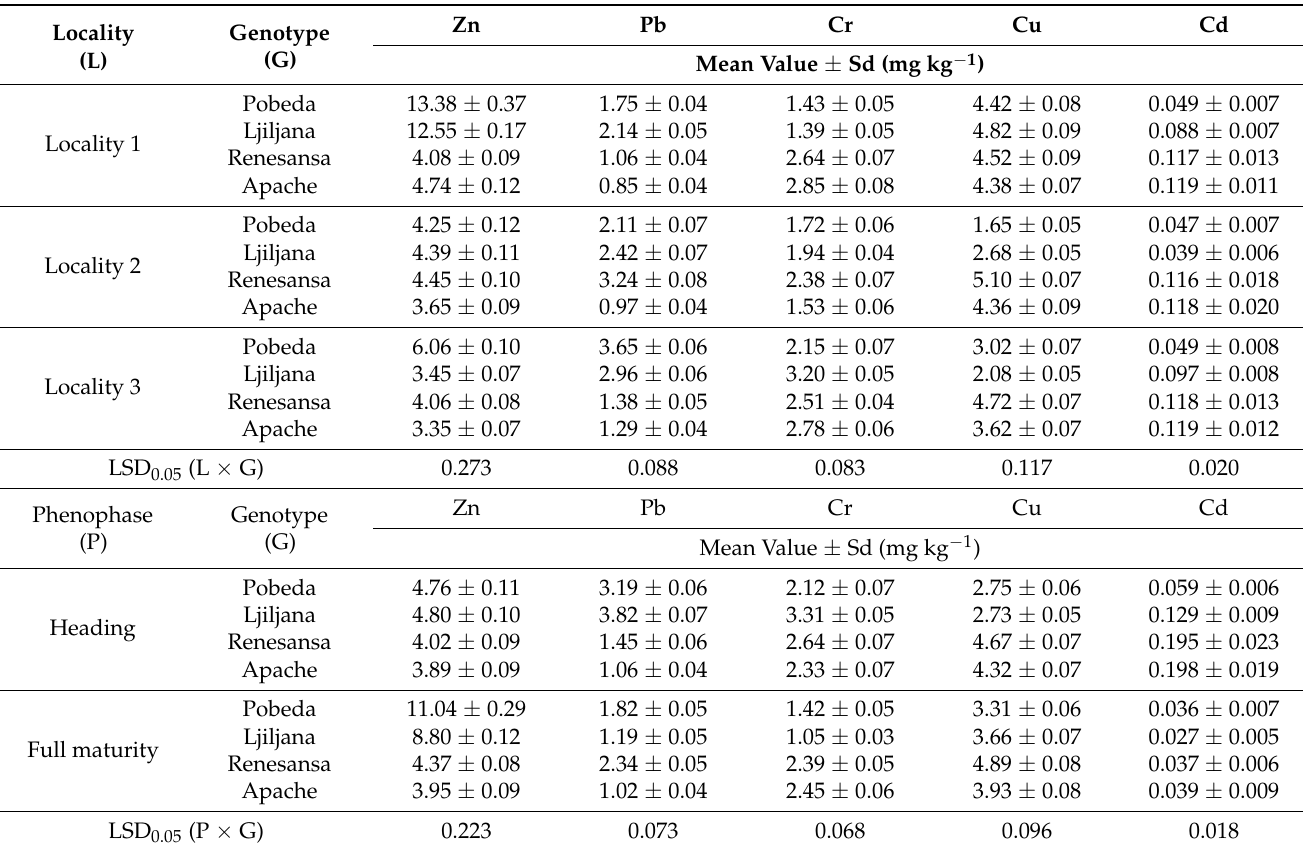
Table 2. Heavy metal content (mean values ± standard deviation of sample means) in roots of four wheat genotypes per locality (average values for both phenophases) and per phenophase (average values for three